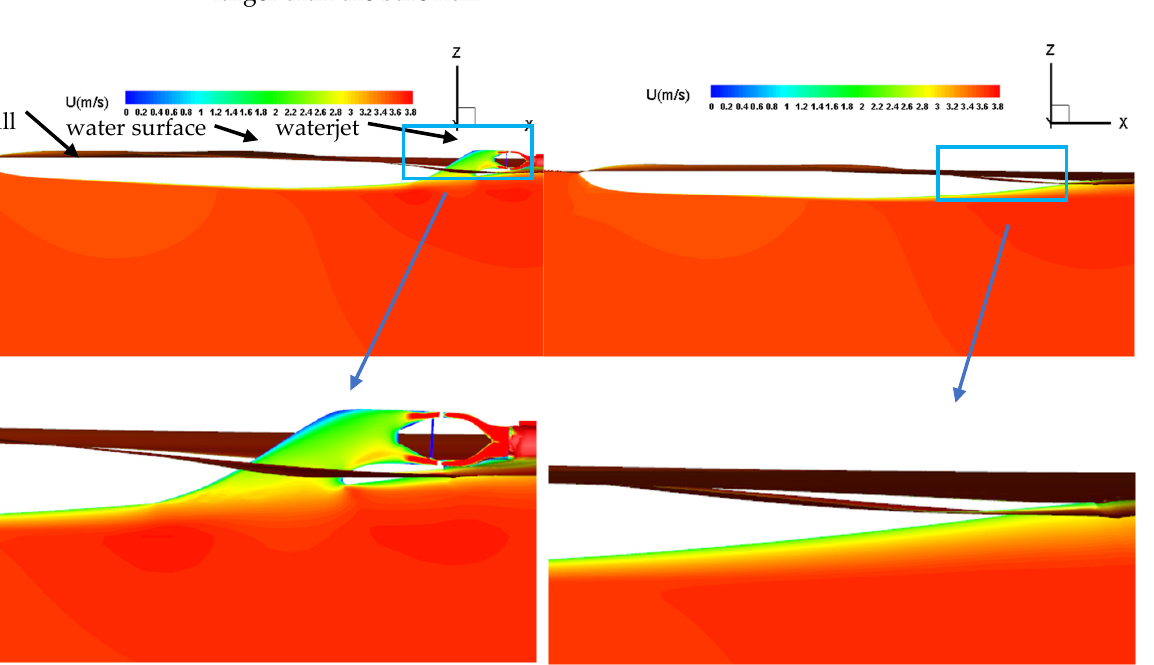
Figure 18. The velocity around the stern of the catamaran.